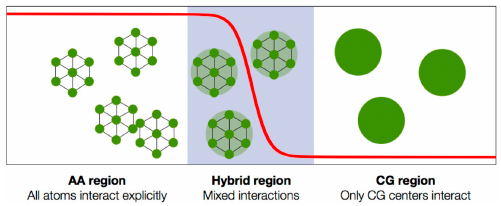
Figure 15. Representation of an adaptive resolution simulation in which a high-resolution region (AA region) is coupled to a low-resolution region (CG region). In the AA region, the structure of the molecules are described in their full atomistic details. In the CG region, however, a simpler representation of the structure and interactions of the molecules are utilized. A transition region is used to connect these regions. The novelty as well as difficulty of adaptive resolution schemes depends strongly on the properties of the transition region, i.e., the way molecules change their resolution. Reprinted from Potestio et al. [337] under the terms of the Creative Commons Attribution License.